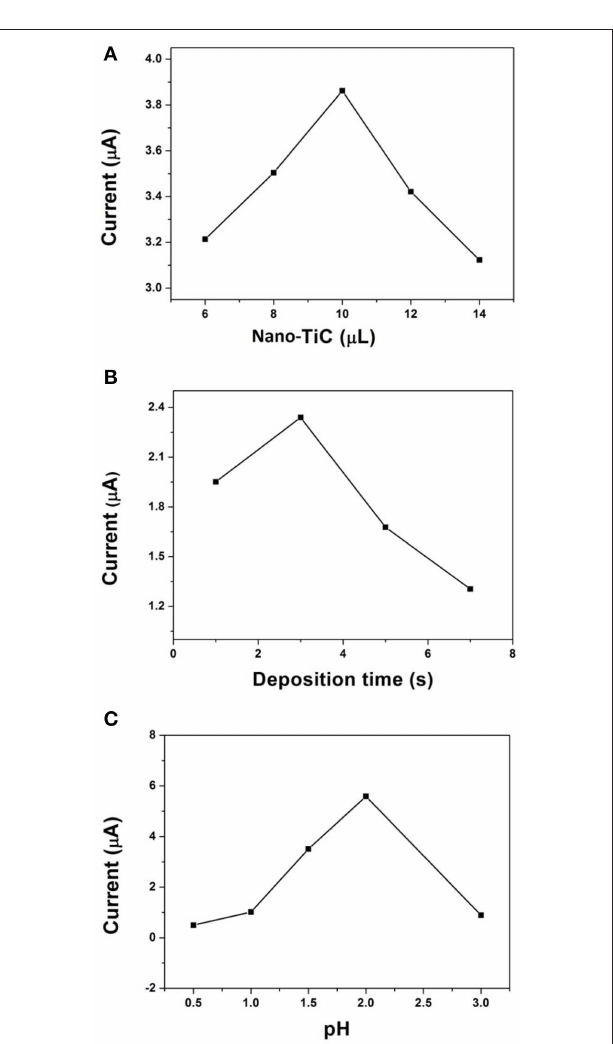
FIGURE 4 | Effect of Nano-TiC volumes (A), electrodepositing time (B), and pH values (C) on the DPV signals for 520 µ g L − 1